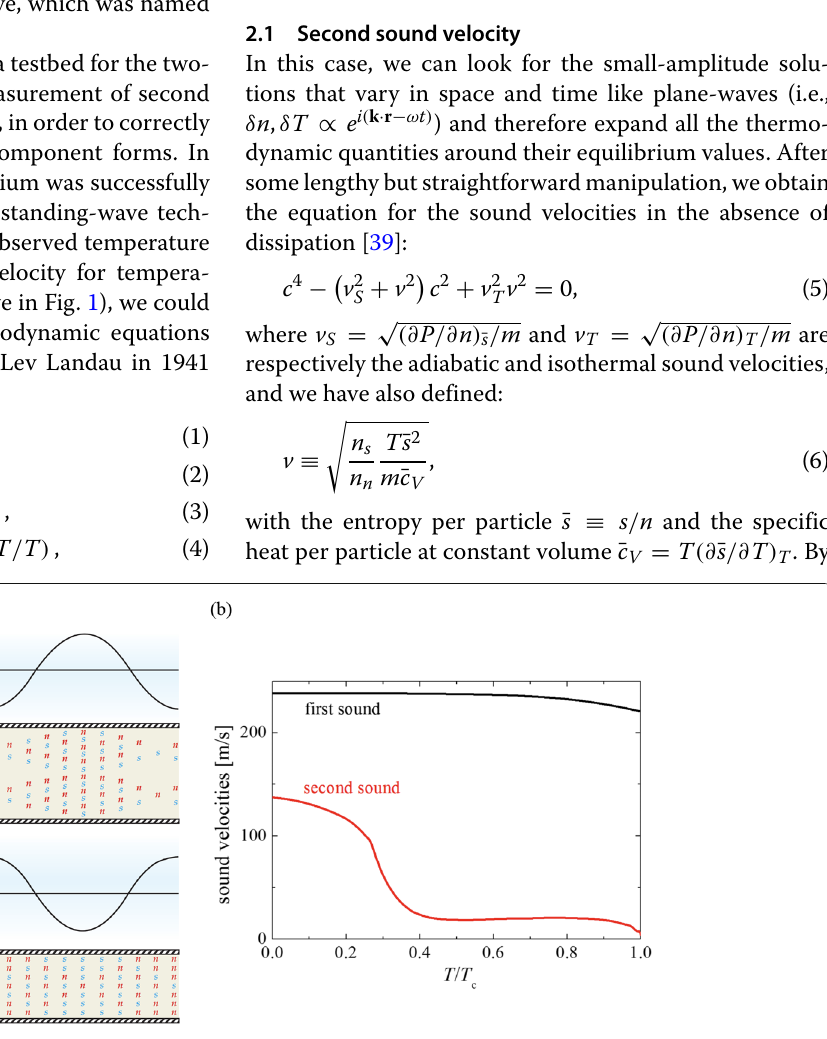
Fig. 1 a The characteristics of the two sounds: the in-phase motion (first sound) and the out-of-phase motion (second sound) between the normal and superfluid components, which are shown by the red circles with “n” and the blue circles with “s”. b First and sound velocities of superfluid helium as a function of the reduced temperature T / T c , where T c (cid:3) 2.17 K is the critical temperature. Adapted from Ref. [1] and Ref.